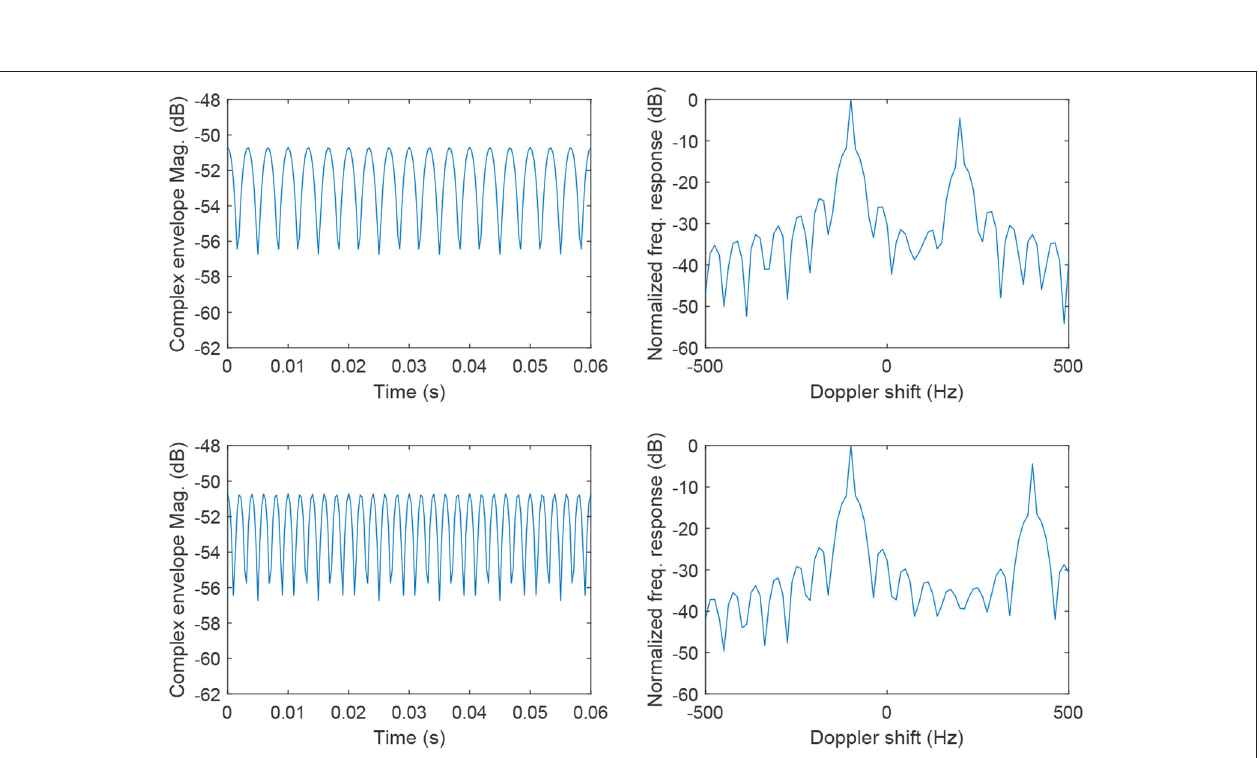
Frontiers in Communications and Networks |